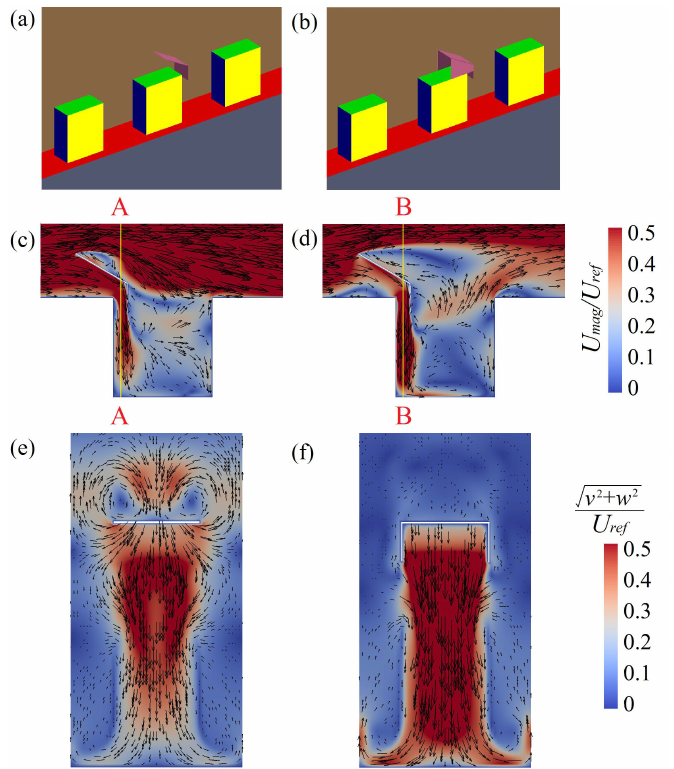
Figure 17. ( a ) Wind catcher and ( b ) wind catcher with sidewalls. Normalized velocity magnitude contours and vectors in canyon 4 for ( c ) wind catcher and ( d ) wind catcher with sidewalls. Normalized span-wise and vertical velocity contours and vectors of ( e ) section A-A and ( f ) section B-B.